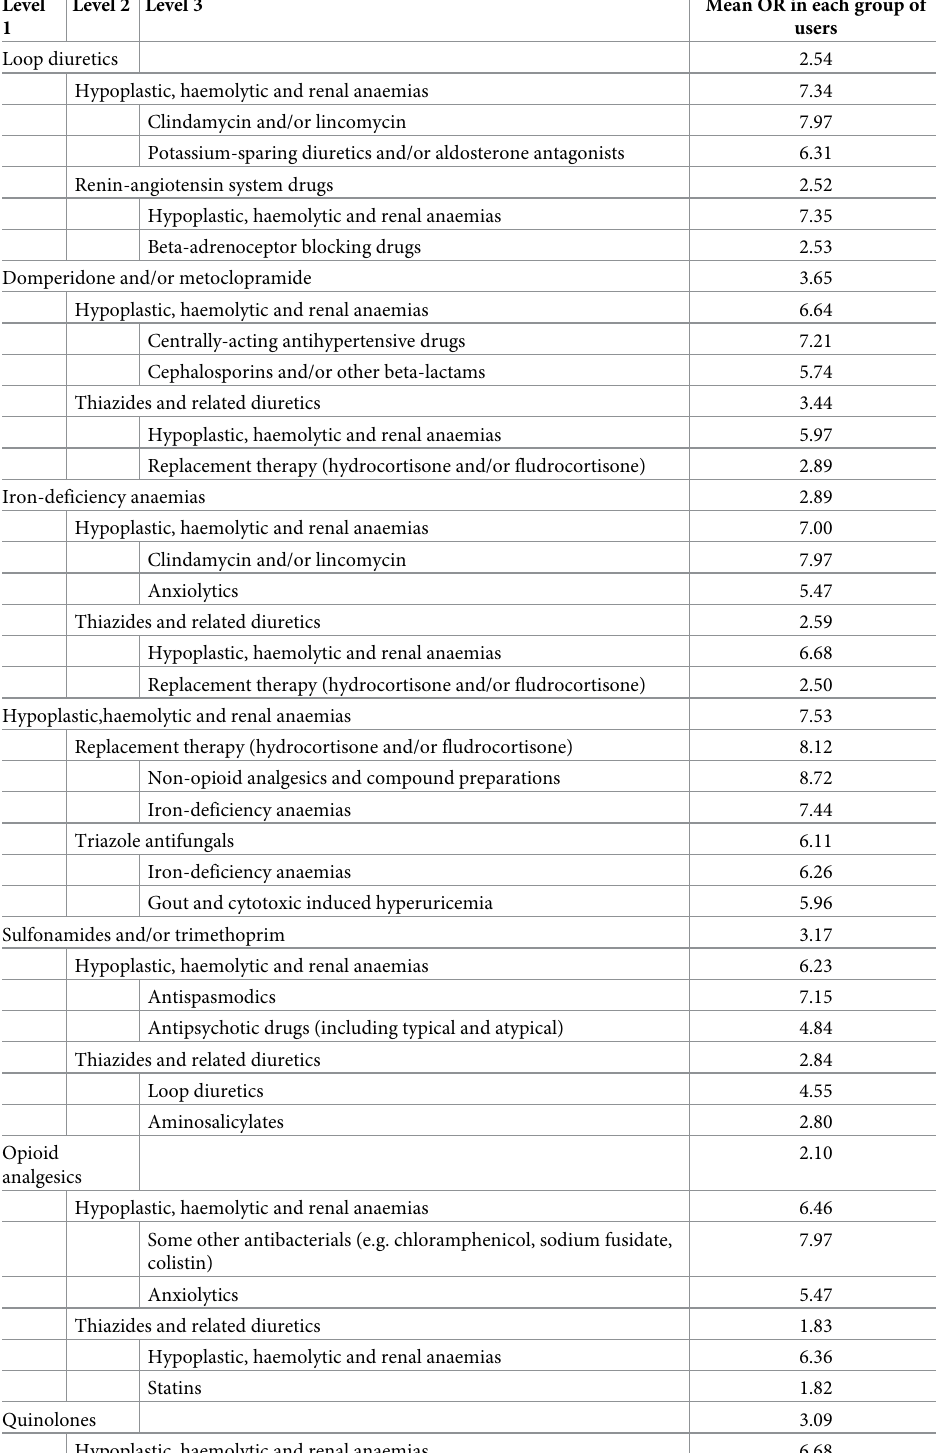
Table 5. ORs for ADR-related hospital admission for example combinations of medicines based on predictions by random forest